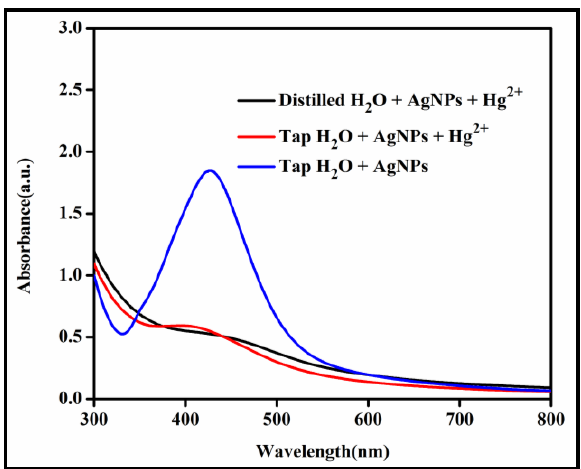
Figure 6. UV Spectrum shows detection of Hg 2+ in laboratory tap